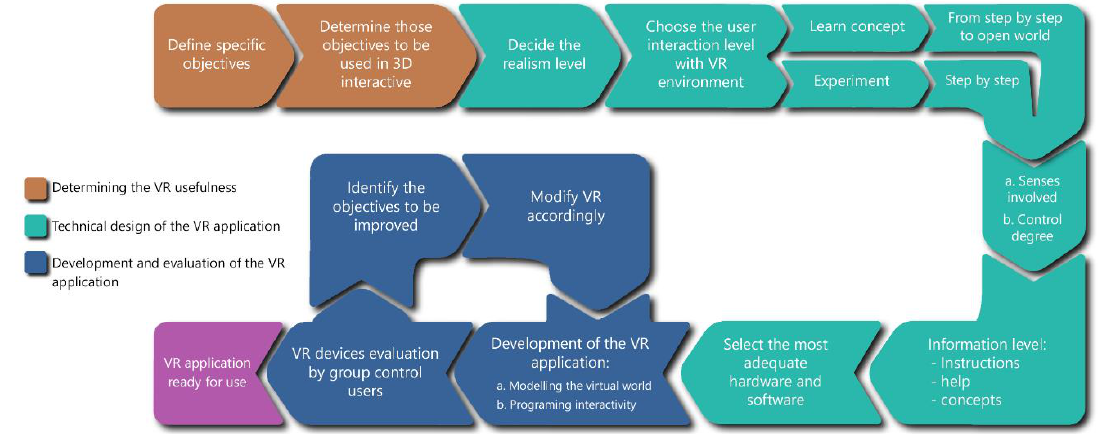
Figure 4. A newer design process, including a step-by-step protocol, as described in this publication.